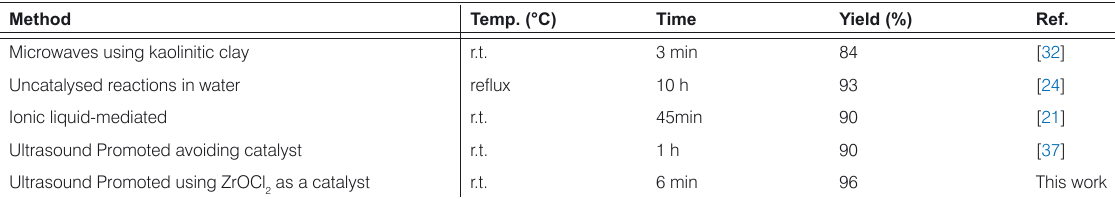
Table 2. Comparison of our results with some previously reported data for the synthesis of compound 3a